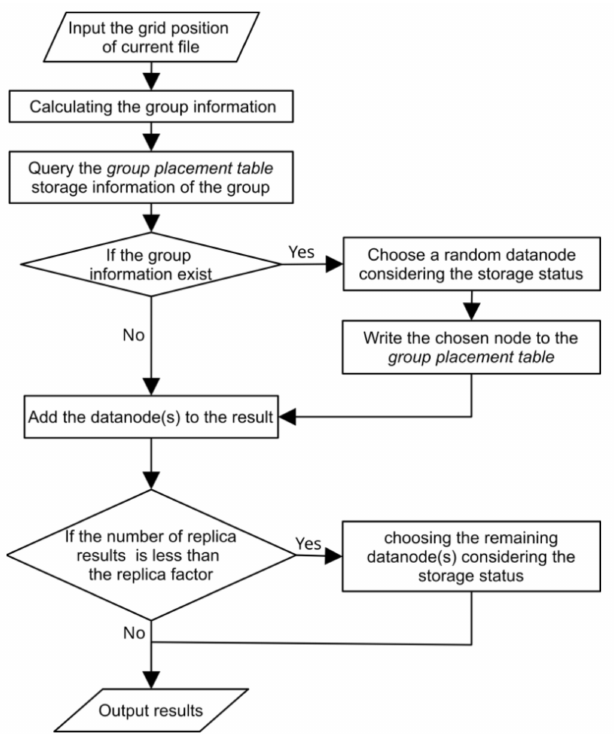
Figure 5. Flowchart for optimized method of chooseTarget. Storage locations of divided grid files are chosen considering the group information and storage status of